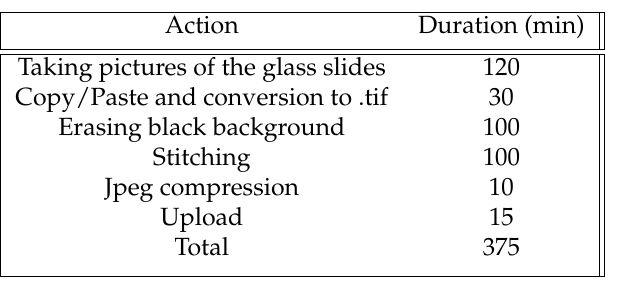
Figure 3. The obtained stitched virtual slide, with the different pieces highlighted with the circles Table 1. Details about the procedure